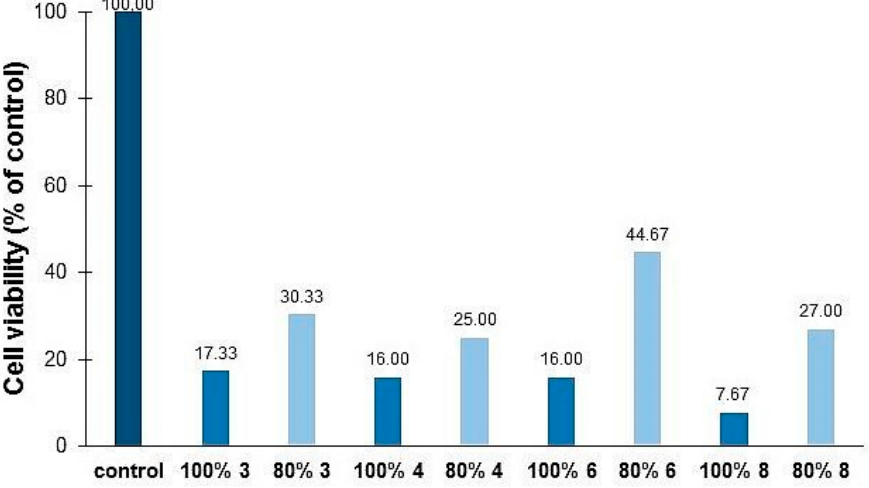
Figure 8. The fungicidal activity of selected goldenrod honey samples (no. 3, 4, 6 and 8).